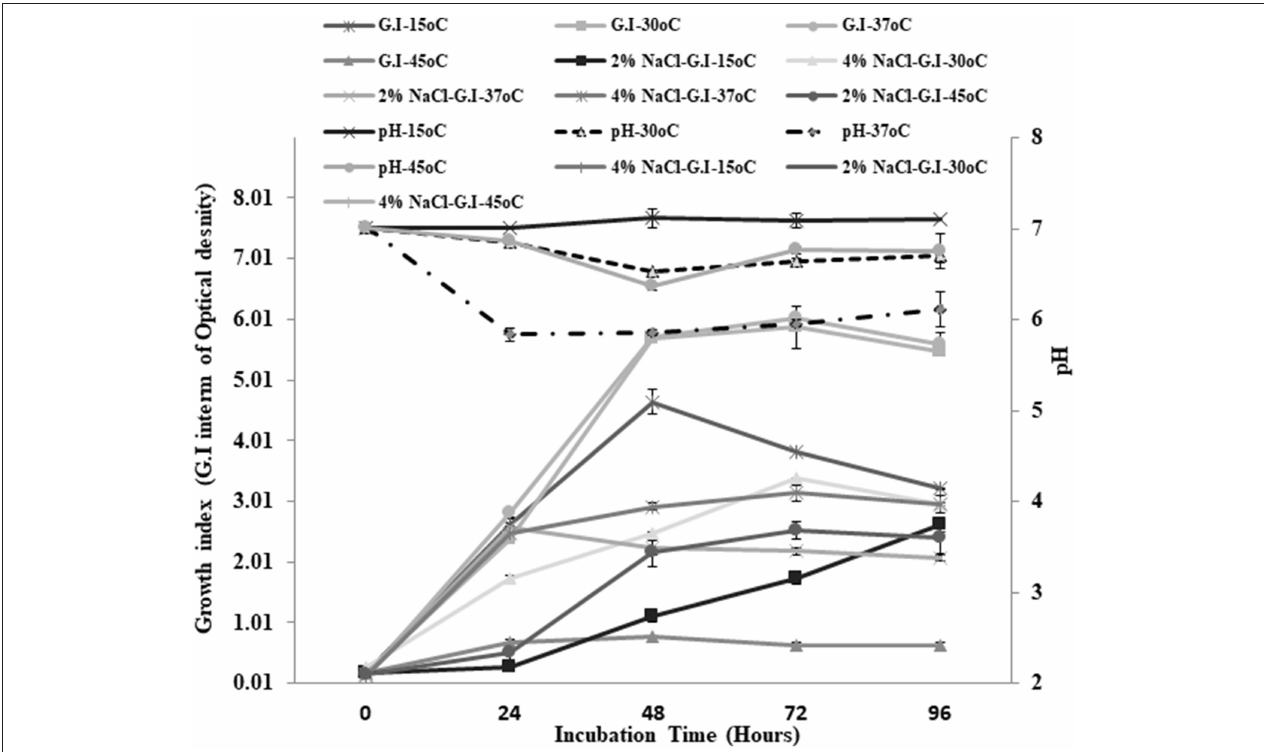
FIGURE 1 | Growth at different temperatures and different NaCl concentrations for QAUEM2808 Y axis presents growth index, Y axis indicates incubation time, Z axis presents pH values, Ligands are above the figure.